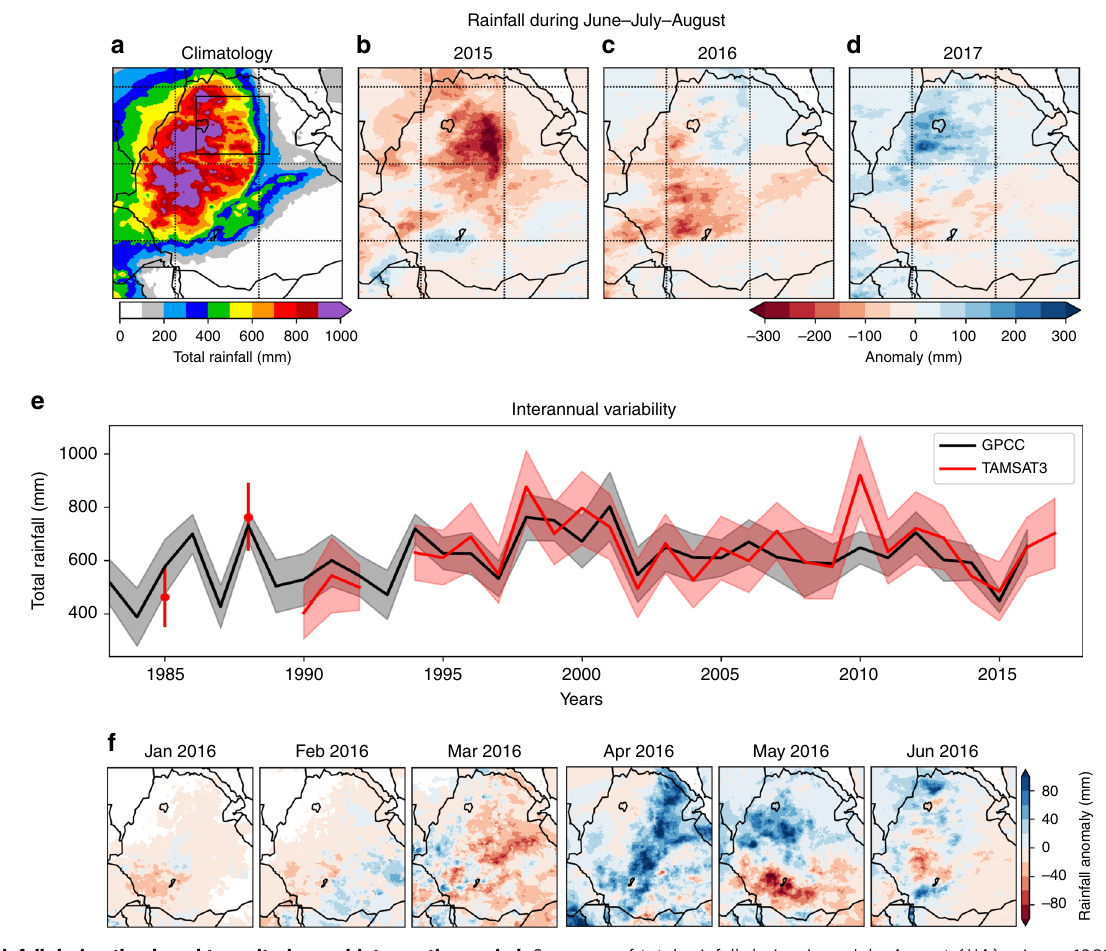
Fig. 2 Rainfall during the drought monitoring and intervention period. Summary of total rainfall during June – July – August (JJA) rains. a 1983 – 2013 JJA climatology. b – d 2015, 2016 and 2017 JJA anomalies relative to a . e Interannual variability in JJA total rainfall over the study area from TAMSAT and the station-based GPCC Full Data Reanalysis version 8 62 , the solid lines represent the regional mean while the shading represents the regional standard deviation. f Rainfall anomaly for the period of the monitoring survey relative to a . Rainfall data is estimated from the University of Reading ’ s Tropical Applications of Meteorology using SATellite data and ground-based observations (TAMSAT © ) product 63 . a – e is adapted from MacDonald et al. 8 . Maps are based on data from the digital chart of the World